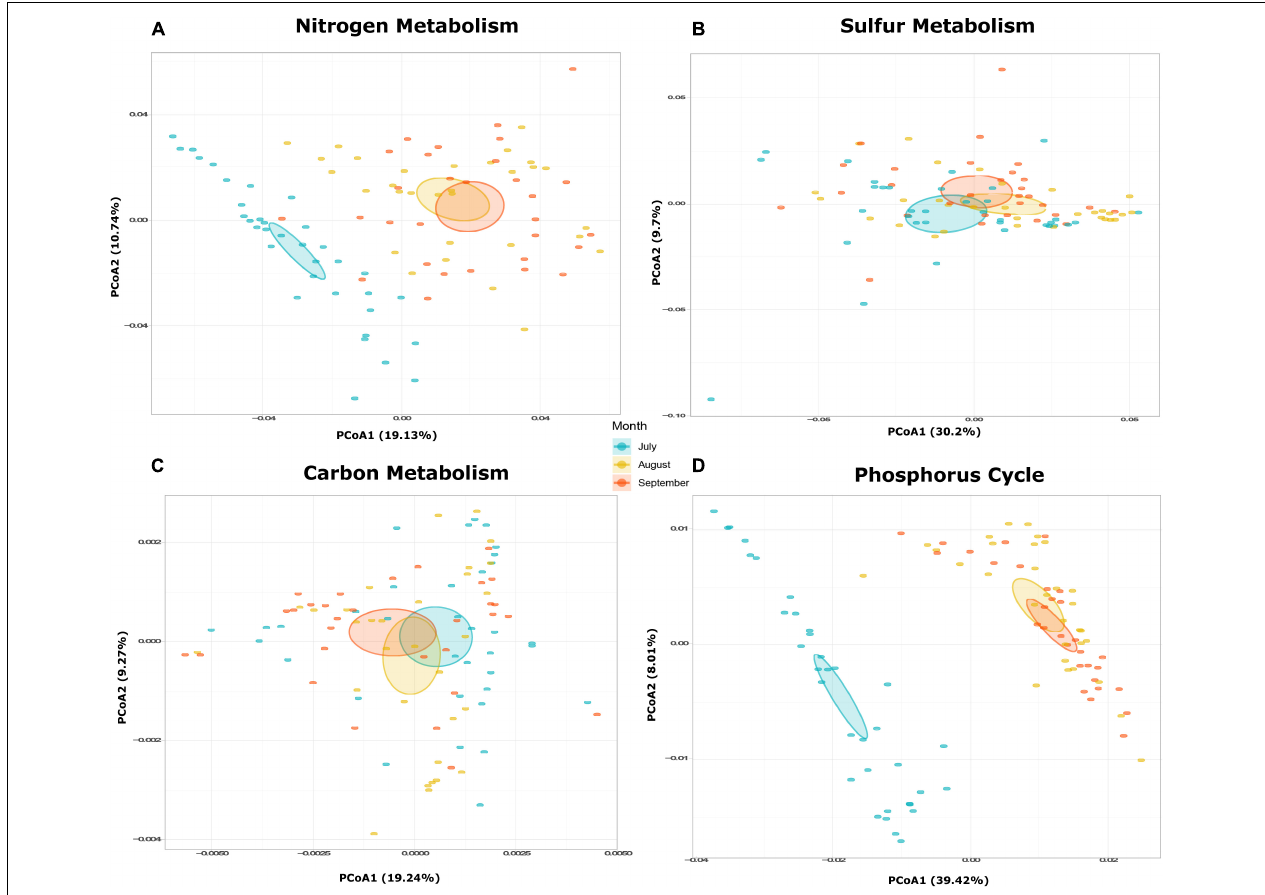
FIGURE 4 | (A) Functional differences during July, August, and September. PCoA of potential function composition in terms of overall functions for (A) nitrogen metabolism, (B) sulfur metabolism, (C) carbon metabolism, and (D) phosphorus